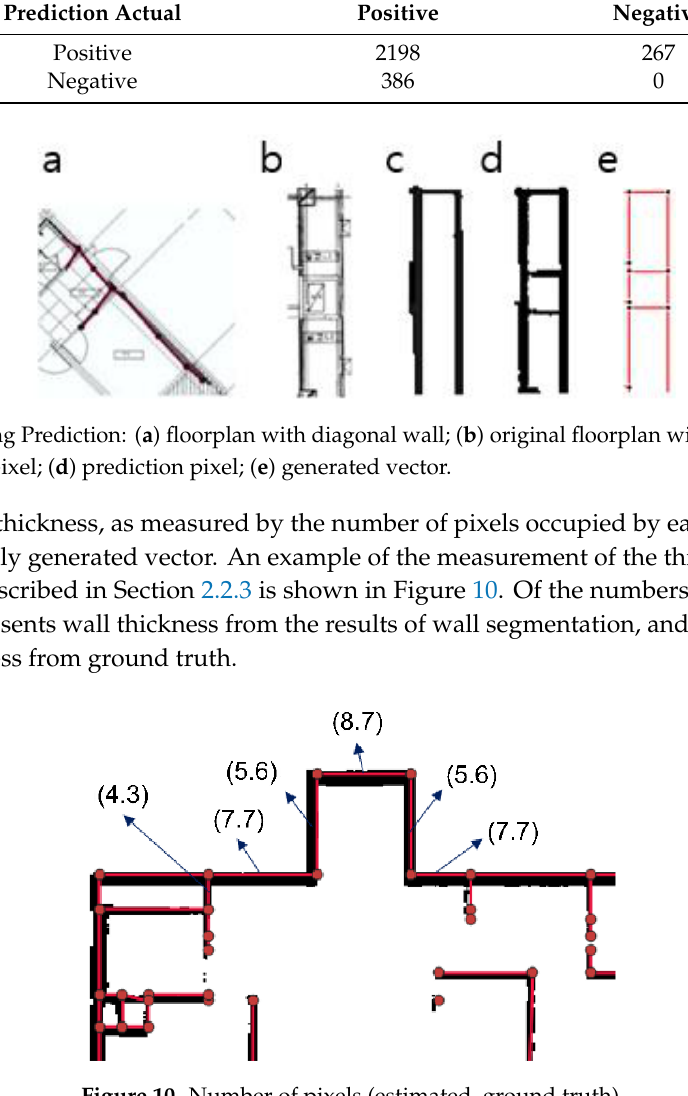
Table 10. Confusion matrix of node extraction.